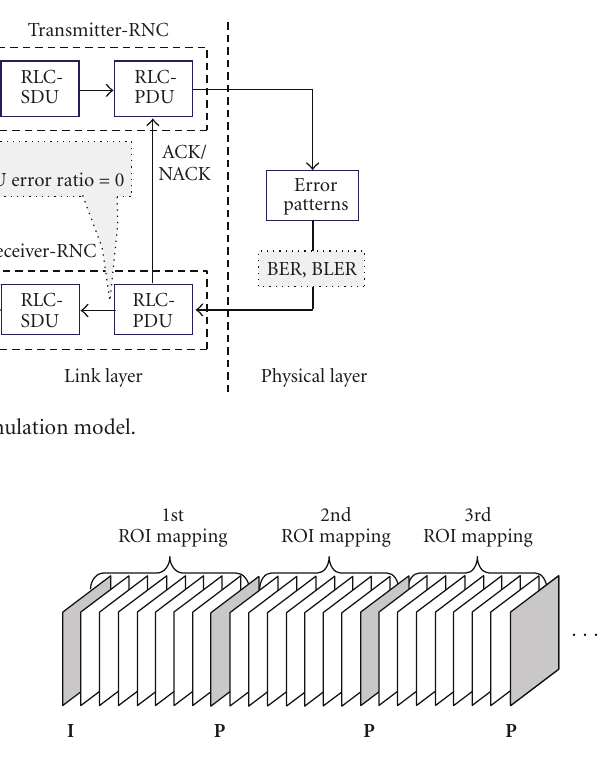
Figure 8: Prediction mode structure and ROI coding